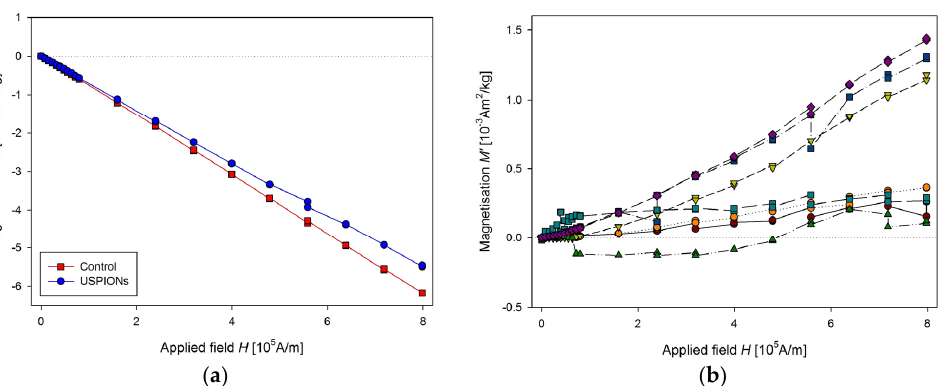
Figure 13. Magnetic properties of the kidney of control and USPION-treated rats. ( a ) The partial M ( H ) dependences at 300 K, ( b ) corresponding M ’ data for individual rats of the USPION-treated group after subtraction of the control group average. Data ( a ) are presented as the averaged curve from the control group ( n = 6) and USPION-treated group ( n = 7). The mass of dry samples was in the range of 3–6 mg. The smaller cutting tool was used (diameter of 3.5 mm). Samples of the aorta were cut to a length of 5 mm and prepared similarly to tissue samples. The measured mass magnetisation is presented in Figure 14.